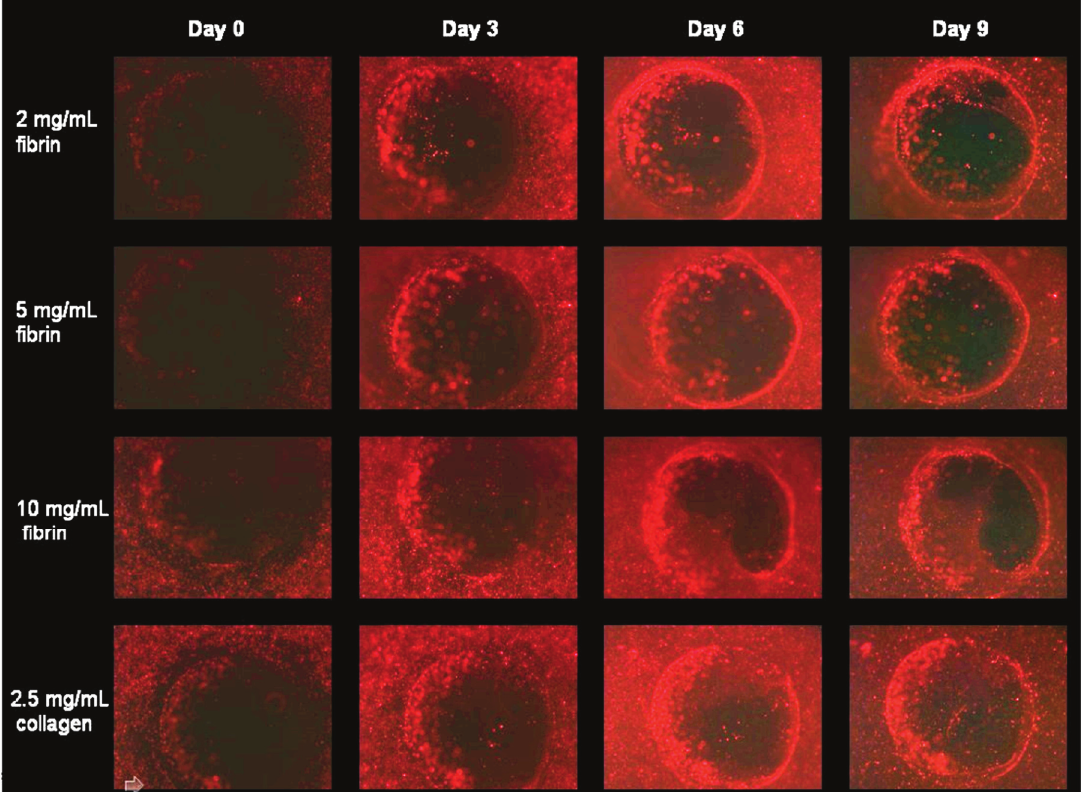
Figure 8 . Three-dimensional wound migration assay with the mold model. Migration of human epidermal keratinocytes from collagen construct to various defects was investigated. No migration was observed. Images taken at 2.5 ×